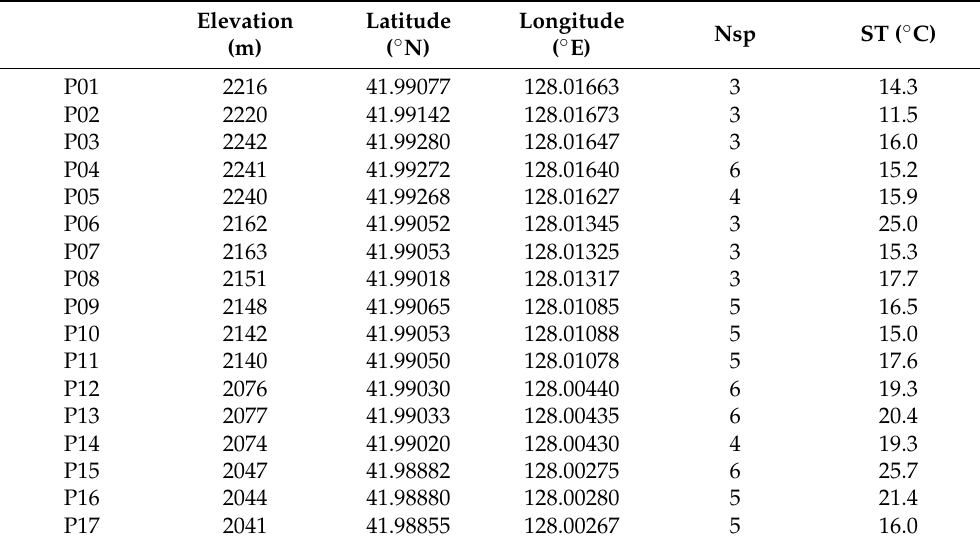
Table 1. Basic information of D. angustifolia natural population sampling points.